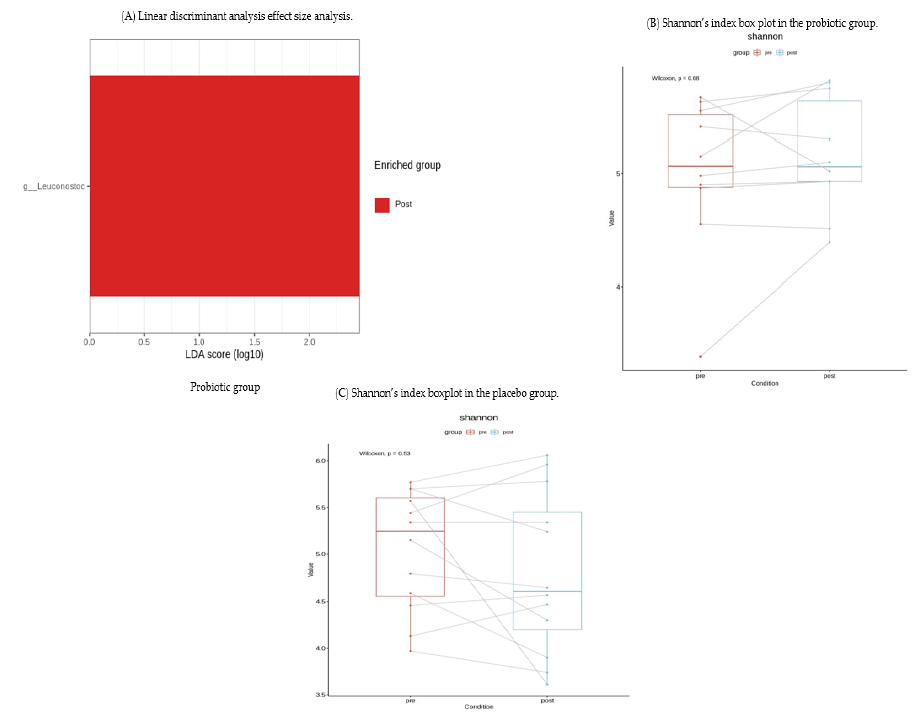
Figure 4. Effect of the probiotic on gut microbiota composition. ( A ) Leuconostoc genus organisms were significantly increased in the probiotic group only compared with before treatment (LDA = 2.458, p = 0.002). No statistically significant bacteria were found in the placebo group (data not shown). g_ Leuconostoc, genus Leuconostoc. ( B ) In the probiotic group, Shannon diversity showed no difference before and after treatment. ( C ) In the placebo group, Shannon diversity showed no difference before and after